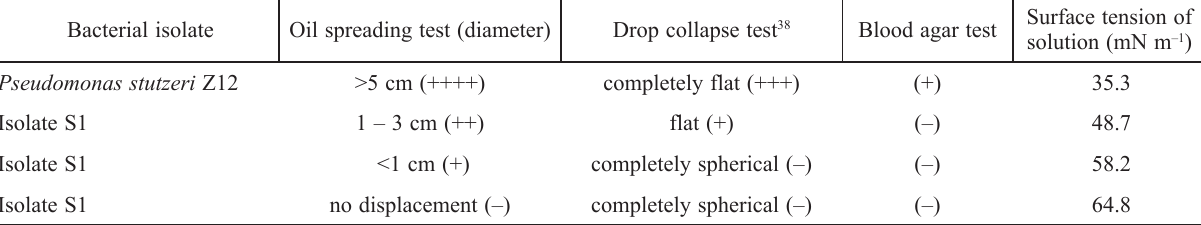
Surface tension of solution (mN m –1 )